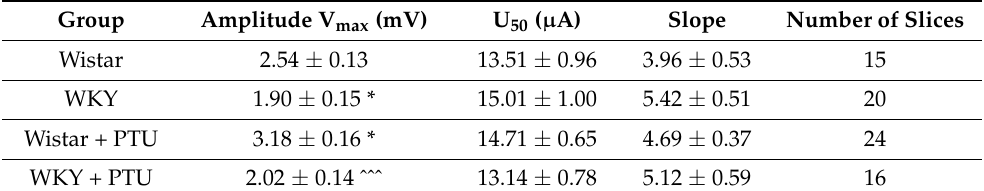
Table 2. Input-output relationship plots in the dentate gyrus (DG) region of the hippocampus. The results are expressed as the mean ± SEM. * p < 0.05 vs. the control group (Wistar rats); ^^^ p < 0.001 vs. Wistar rats treated with PTU.